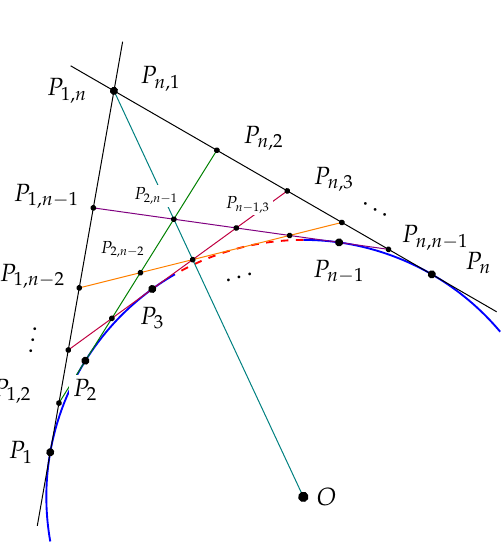
Figure 7. Line segments defined by refinements of a circumscribed